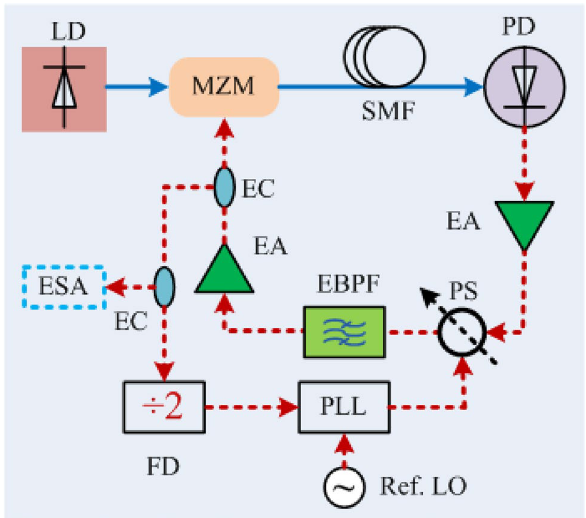
Figure 6. Schematic diagram of the experimental setup for phase locking the OEO to the reference LO PLL Phase lock loop; FD Frequency divide, SSA Signal source analyzer; Ref. LO Reference local